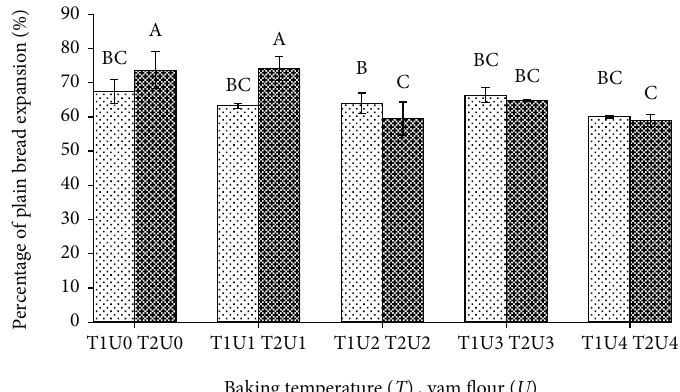
Figure 4: Percentage of plain bread expansion with di ff erent baking temperature and yam fl our addition. Note: T1: baking temperature 170 ° C; T2: baking temperature 180 ° C; U0: yam fl our 0%; U1: yam fl our 10%; U2: yam fl our 15%; U3: yam fl our 20%; U4: yam fl our 30%. The letter above the bar graph beside the same number shows that it is not di ff erent based on the DNMRT statistical test at the level of con fi dence 5%.